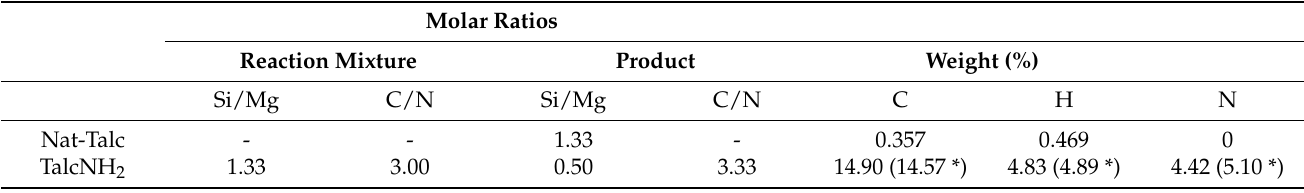
Table 1. Chemical composition of Nat-Talc and TalcNH 2